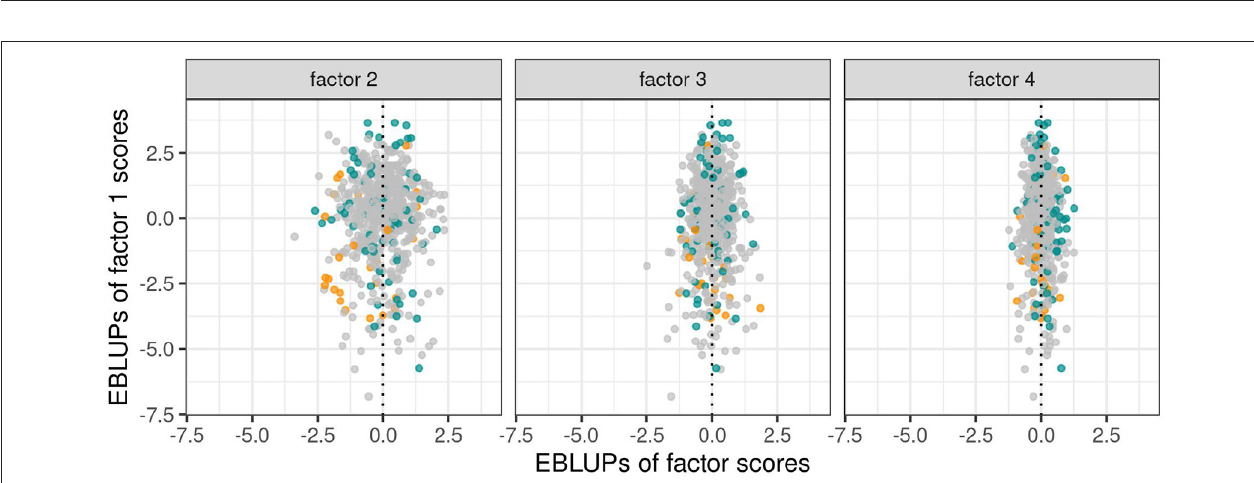
FIGURE 4 | EBLUPs of first factor scores plotted against second, third and fourth factor scores for all varieties. Points are colored orange (check varieties), blue (test varieties of interest) or gray (remaining test varieties).